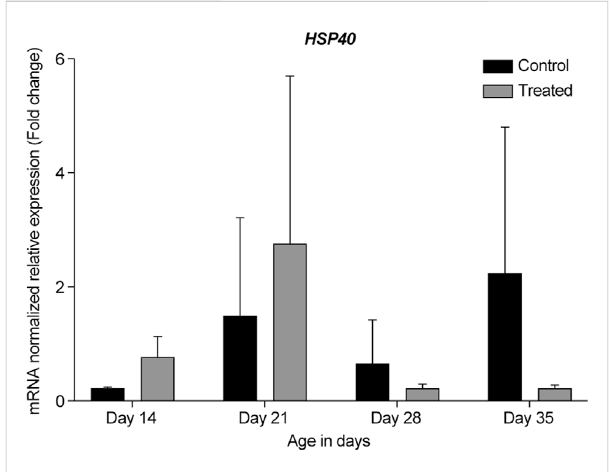
FIGURE 7 ΔΔ Ct oftherelativenormalizedexpressionfor HSP40 inthecontrol (indoor) group and heat-treated (outdoor) chickens at 14-, 21-, 28-, and 35-days of age in the summer of 2021. ( n = 3 in each group). HSP, heat shock protein.